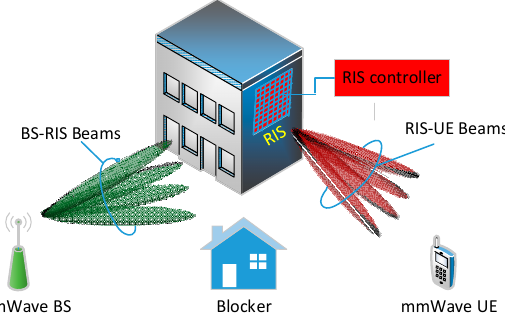
Figure 1. RIS-assisted mmWave communication system.